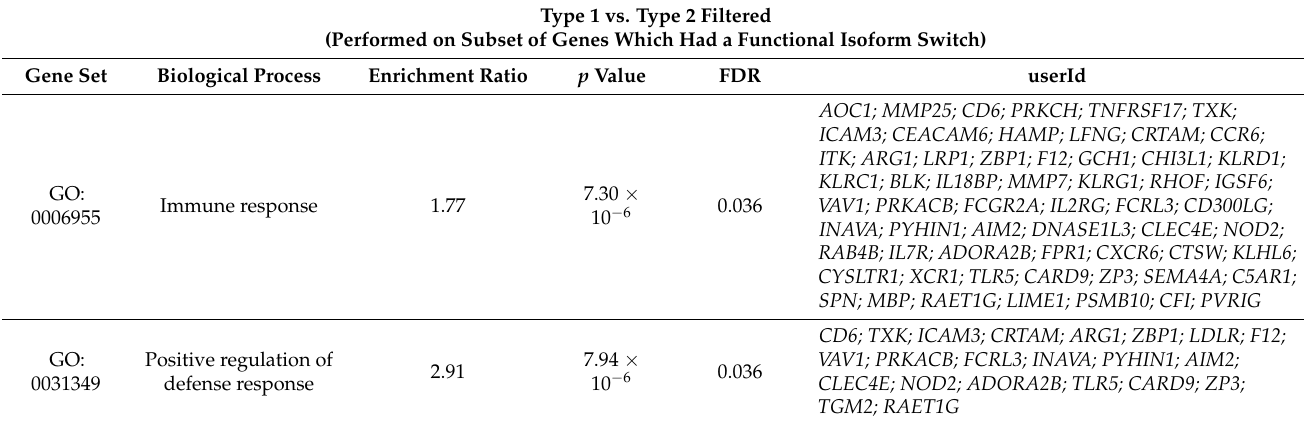
Table 2. Summary of differentially expressed functional splice variants of GO category immune